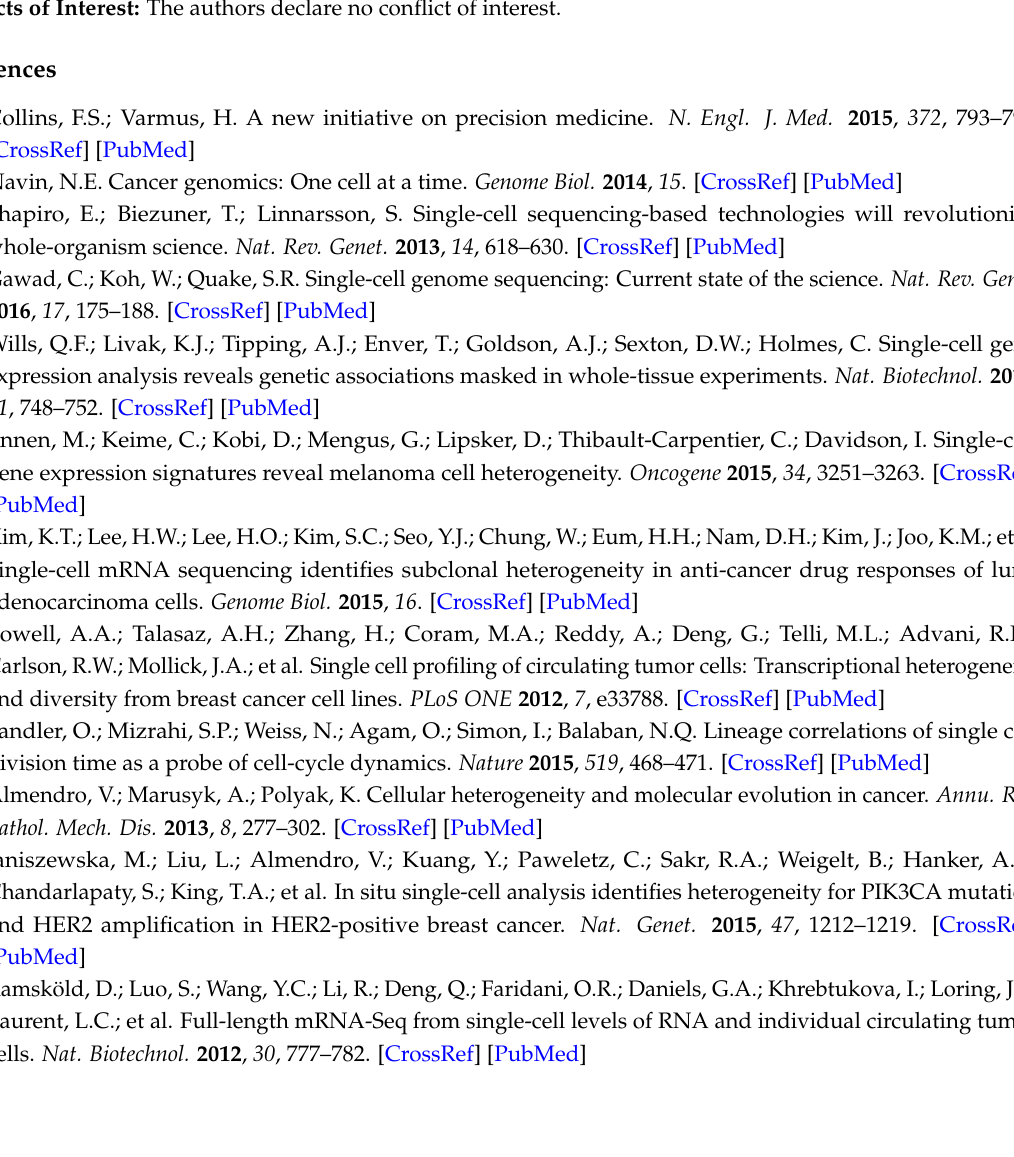
Figure S1: Layout design of the multi-layer microchip. Figure S2: Layout design of the on-chip heater and temperature sensor. Figure S3: (a) 3-D modeling of the microchip in COMSOL; and (b) FEM discretization of the microchip. Figure S4: (a) A microchip prototype; (b) A unit is activated for cell trapping; and (c) Simulation results of the single-cell trapping process. Figure S5: Simulation results of the single-cell trapping process with parametric inlet flow velocity. Figure S6: Fabrication process of the microchip following standard soft photolithography. Figure S7: LabVIEW graphical program and the corresponding front panel for on-chip temperature control of RT-qPCR. Figure S8: Protocol of the on-chip RT-qPCR validation test. Figure S9: End-point fluorescent intensity value of 35-cycle PCR. Figure S10: Corresponding filters and excitation/emission spectra for reporter and reference dyes. Table S1: Properties and classification of the